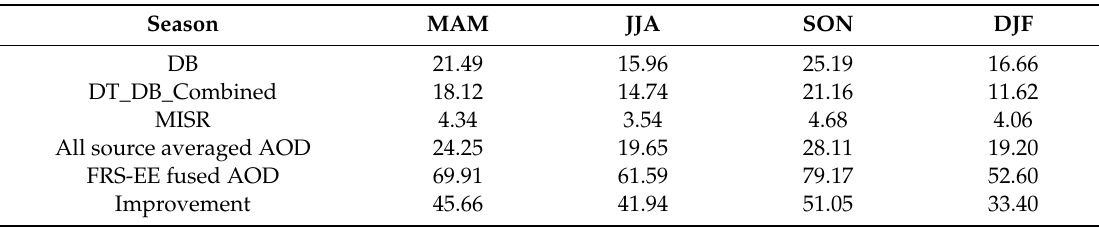
Table2. Seasonalstatisticsofthespatialcompletenessfororiginal, allsourceaveraged,